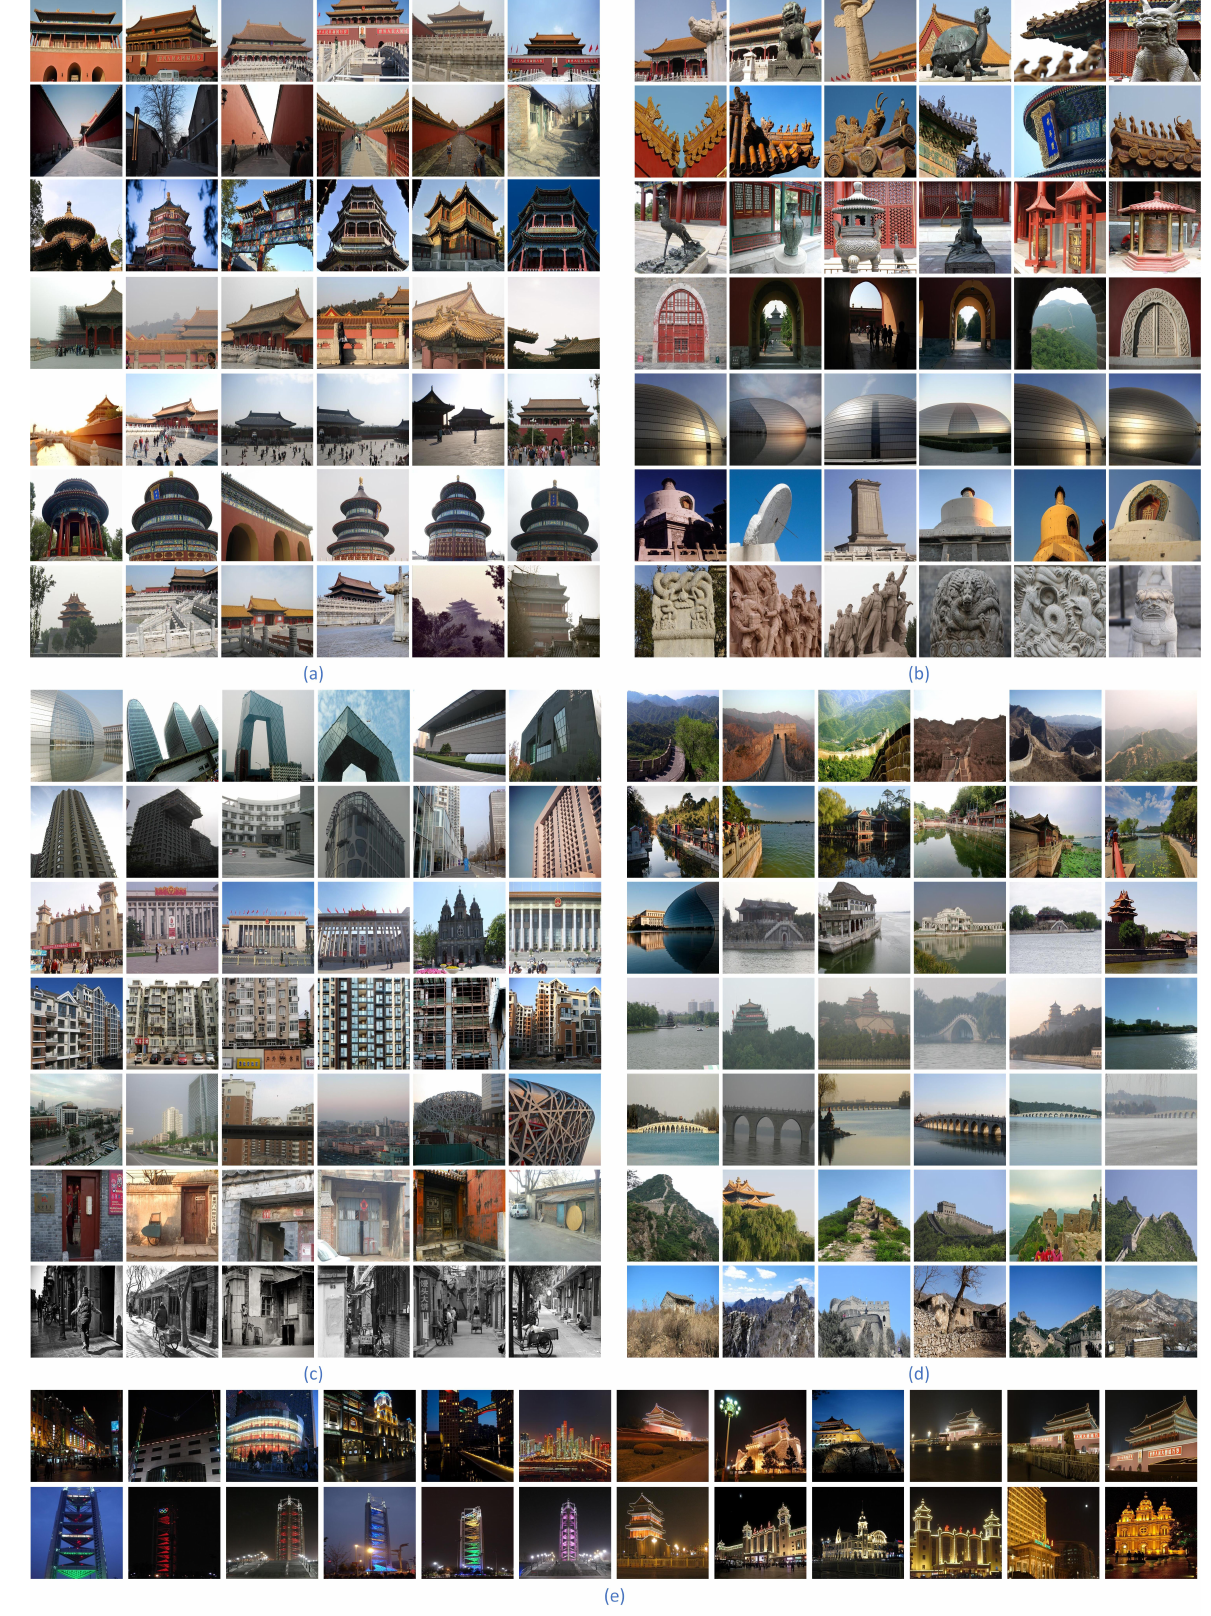
Figure 9. Beijing fine-grained clustering samples display. Beijing can be divided into roughly 5 main categories:ancient buildings ( a ), target objects ( b ), modern landmarks ( c ), some unique landscapes ( d ), and Beijing at night ( e